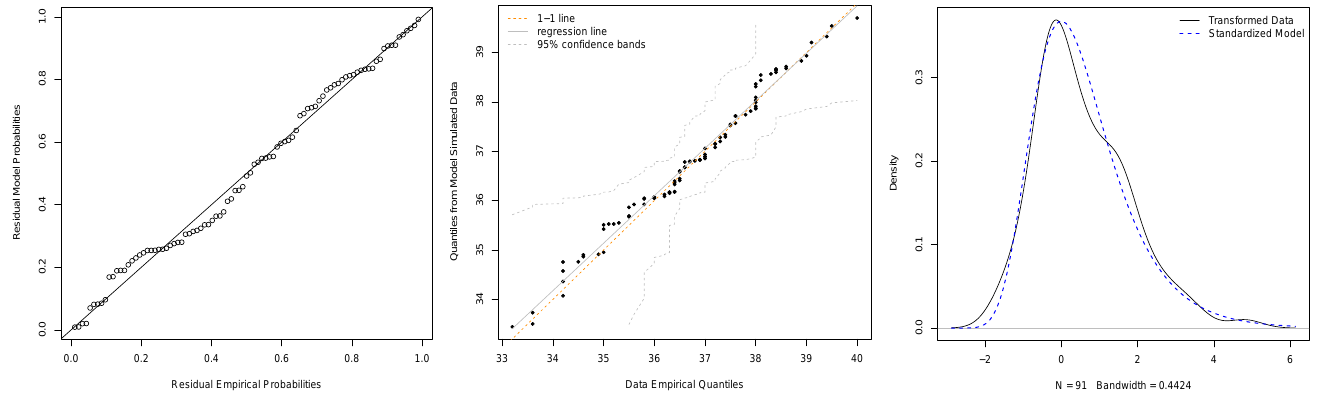
Figure A1. Diagnostic plots of the final GEV model parameters according to the GEV-SSVS selection. Barcelona (1914–2010).